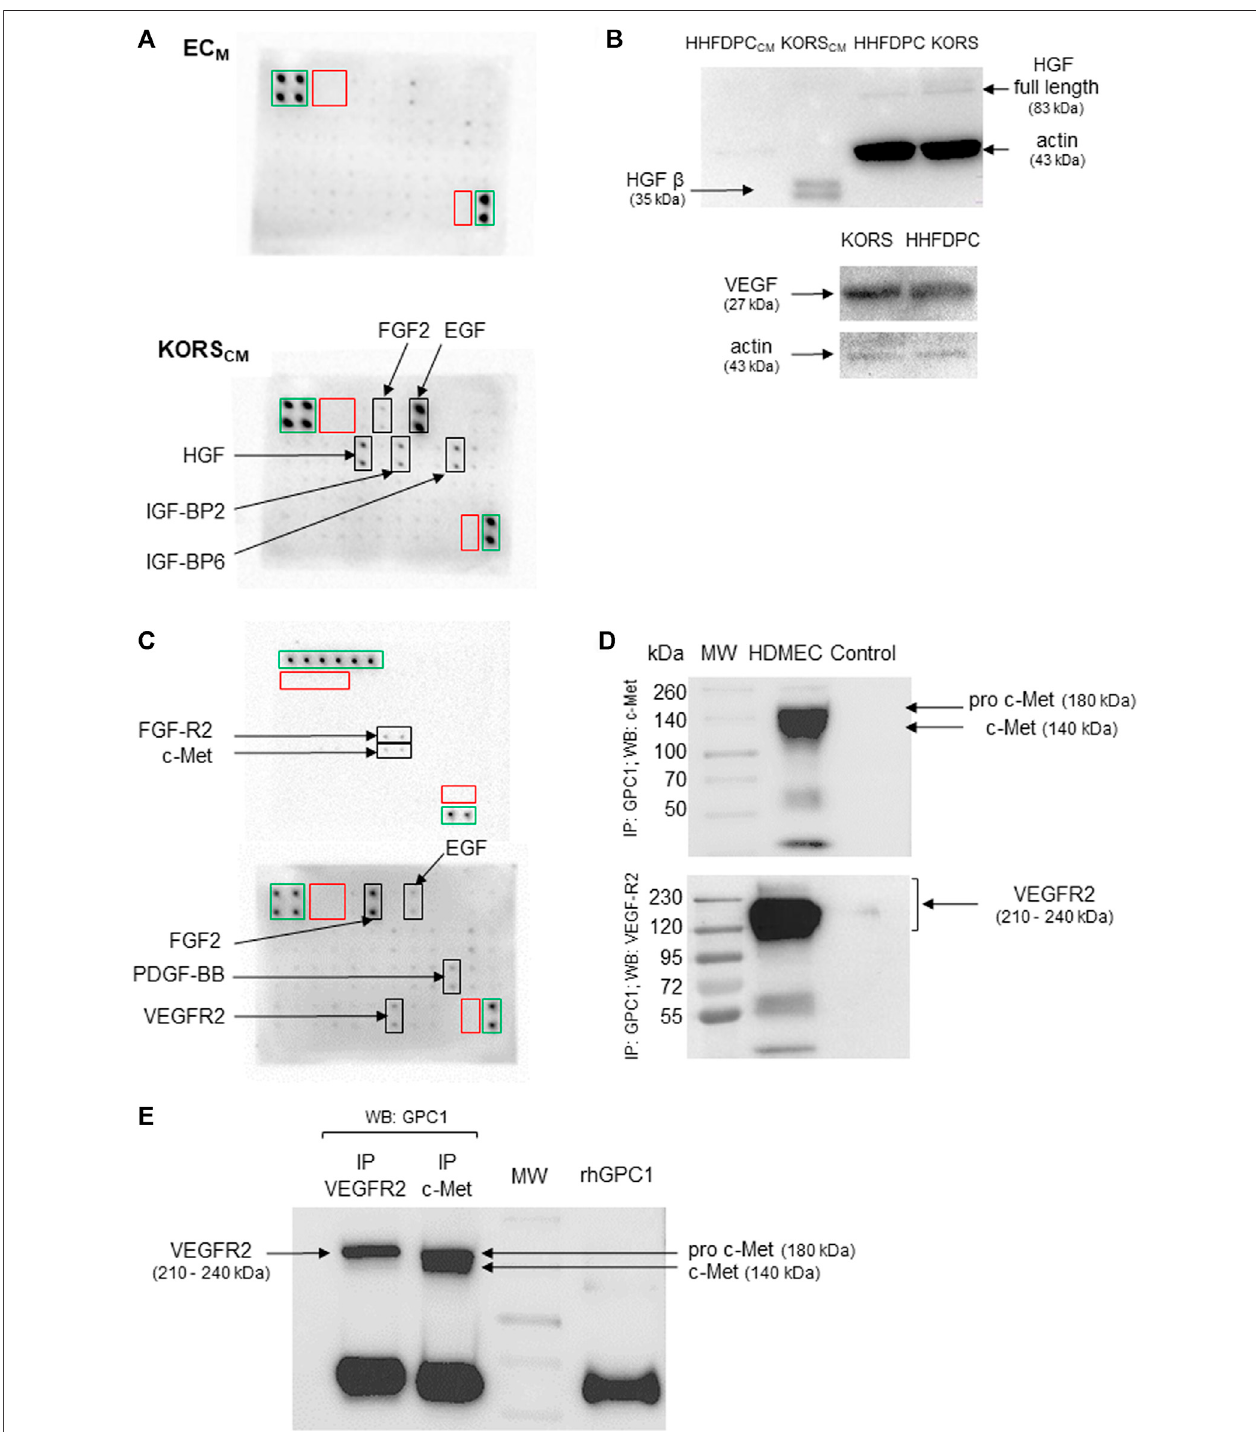
FIGURE8| HDMECexpressthereceptorsforVEGFandHGF,whicharesecreted byKORS. (A) GrowthfactorssecretedbyKORSanalyzed byproteinarrayfrom their conditioned medium (KORS CM ) and compared to the basal cell culture medium (EC M ) without cells. Green frames: positive control spots; red frames: negative control spots; black frames: spots correspondingto the indicated target. (B) The production ofHGF and VEGF in the KORS were compared to that of the HHFDPCs by Western immunoblotting. (C) Growth factors and receptors of HDMECs analyzed by protein array. Green frames: positive control spots; red frames: negative control spots; black frames: spots corresponding to the indicated target. (D) The direct interaction between GPC1 with VEGFR2 or c-Met was analyzed by co- immunoprecipitation. A whole cell protein extract (25 μ g) from the HDMECs was precipitated using anti-GPC1 antibody. Anti-c-Met or anti-VEGFR2 antibody was used